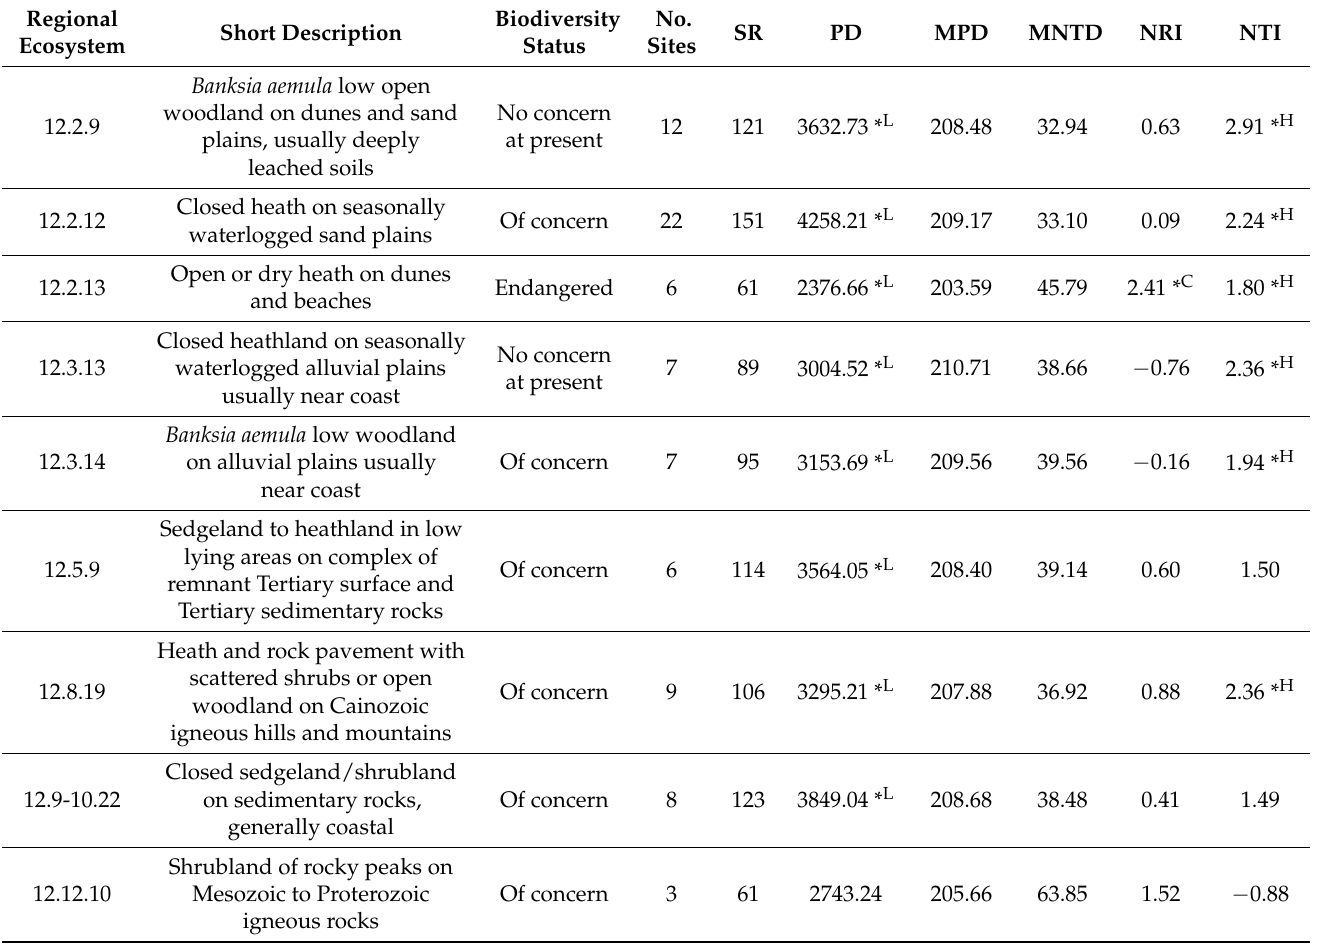
Table 1. Description and diversity metrics of the heathland regional ecosystems on the Sunshine Coast,